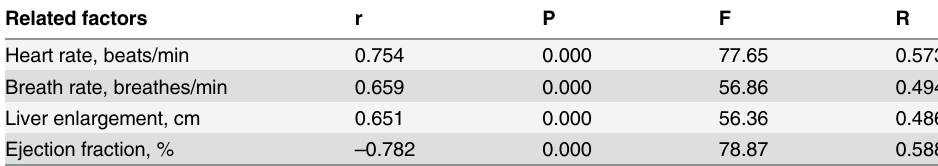
Table 3. The correlation between plasma NT-proBNP level and heart rate, breathe rate, liver enlarge- ment, and Ejection fraction in the all heart failure